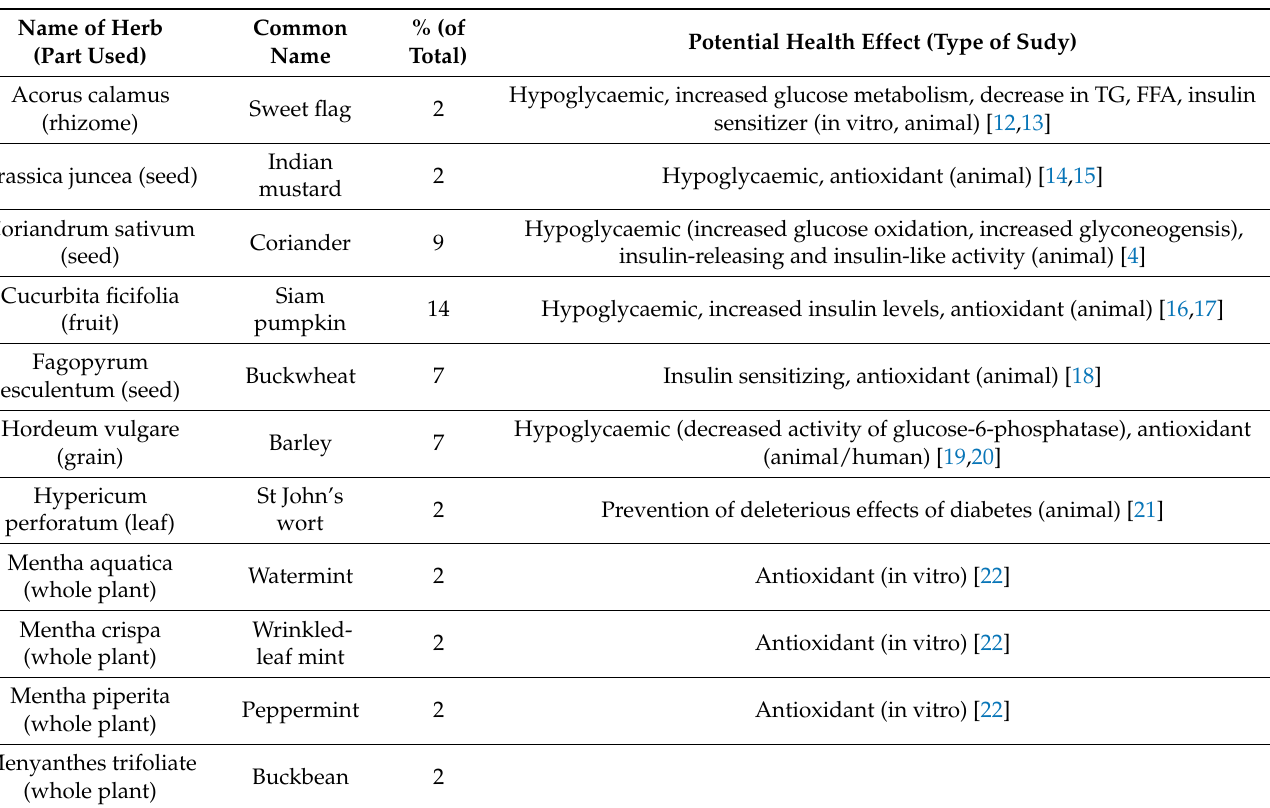
Table 1. Herbs and the amounts (%) used in the herbal supplements and their potentially health effect described in the literature.